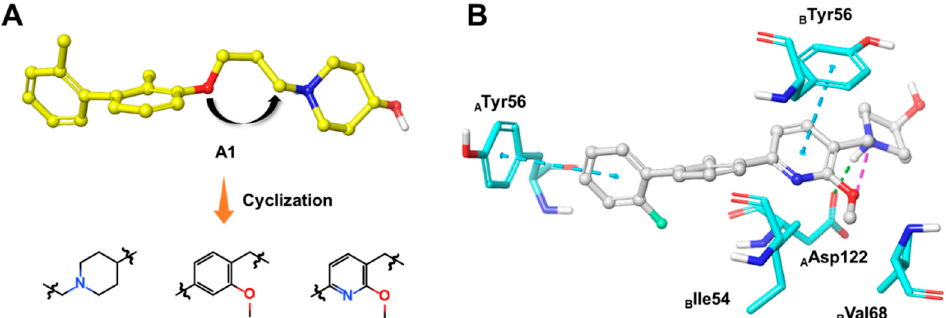
Figure 3. ( A ) The optimization strategy of the linker part. ( B ) Putative binding modes of A4 in the binding pocket of PD-L1 dimer structure (PDB code: 5J89). Dashed lines represent the interaction between A4 and protein, specifically, green ones indicate hydrogen bond, purple ones indicate ionic interaction, and sky-blue ones indicate π – π interaction.